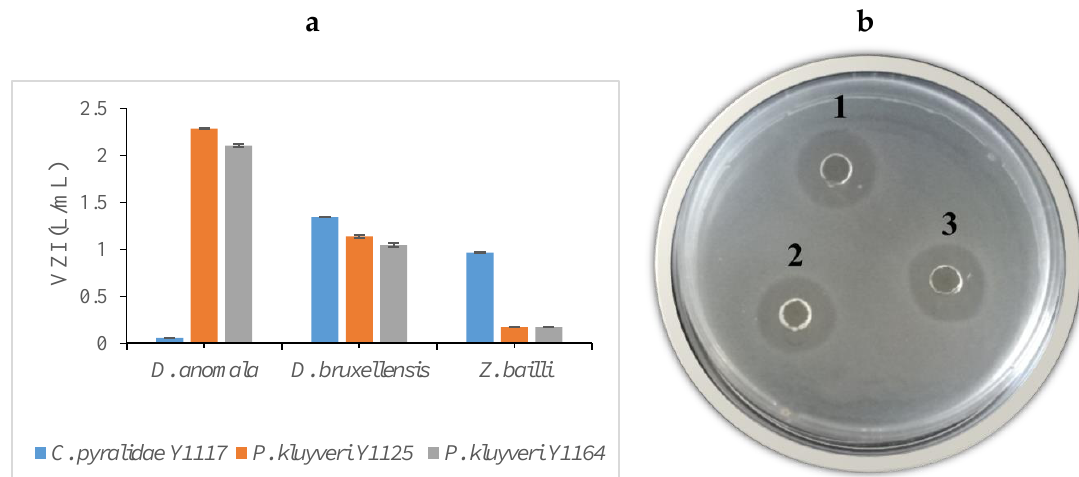
Figure 3. ( a ) Values of the volumetric zone of inhibition (VZI) obtained from the single isolates and their cell free supernatants against spoilage yeasts ( Dekkera anomala, D. bruxellensis , and Zygosaccharomyces bailii ) ( b ) An example of a plate showing the VZI obtained for Candida pyralidae Y1117 (1), Pichia kluyveri Y1125 (2), and Pichia kluyveri Y1164 (3) against Dekkera bruxellensis . The values presented are the means of three replicates with the standard deviation ranging between 0.004 and 0.09.